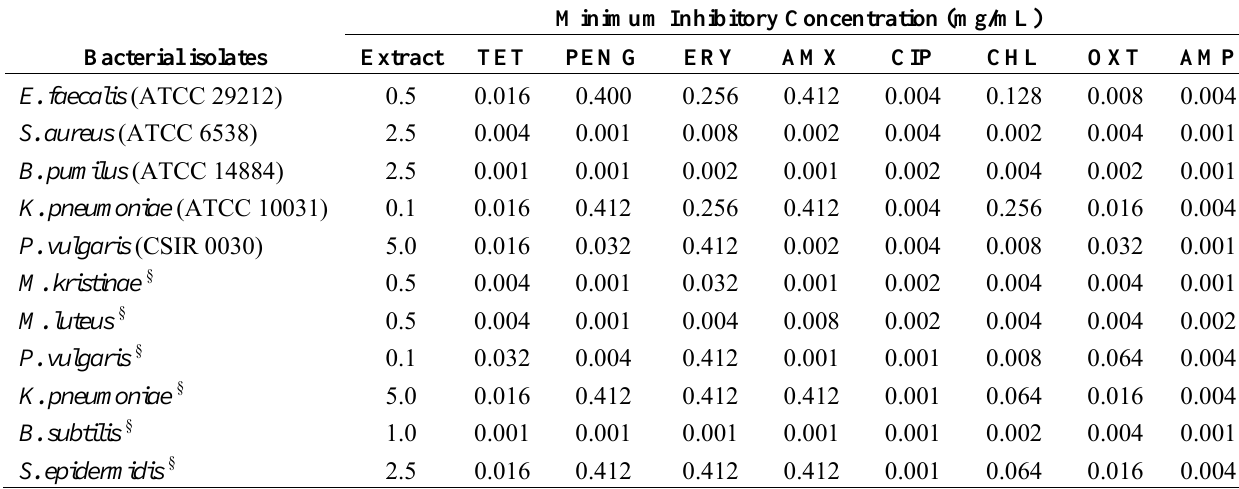
Table 2. The minimum inhibitory concentrations (MICs) of the extract and the antibiotics used. Bacterial